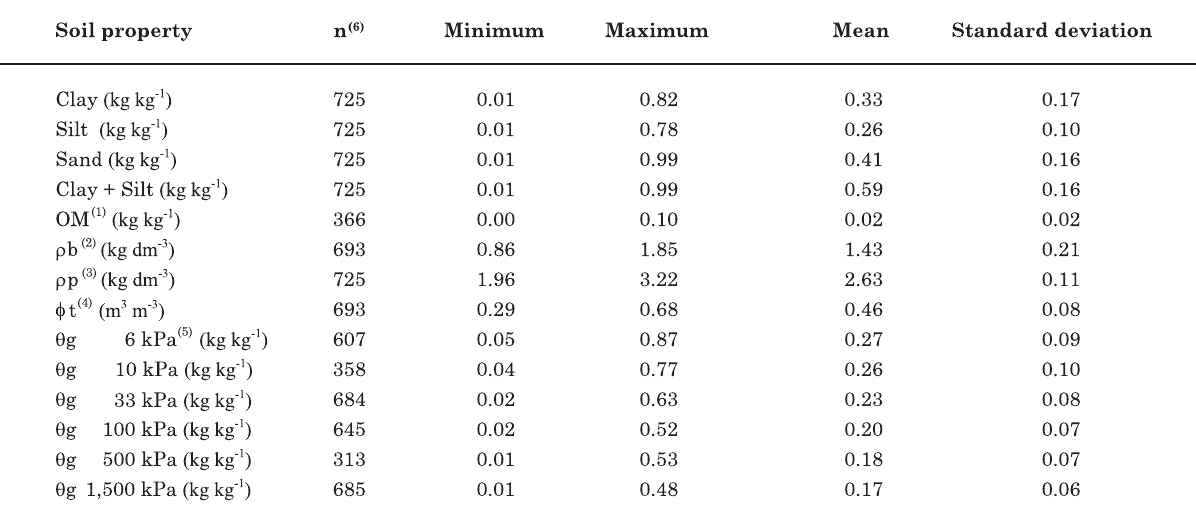
Table 2. Descriptive statistics of the variables that compose the database used to generate the pedotransfer functions for RS